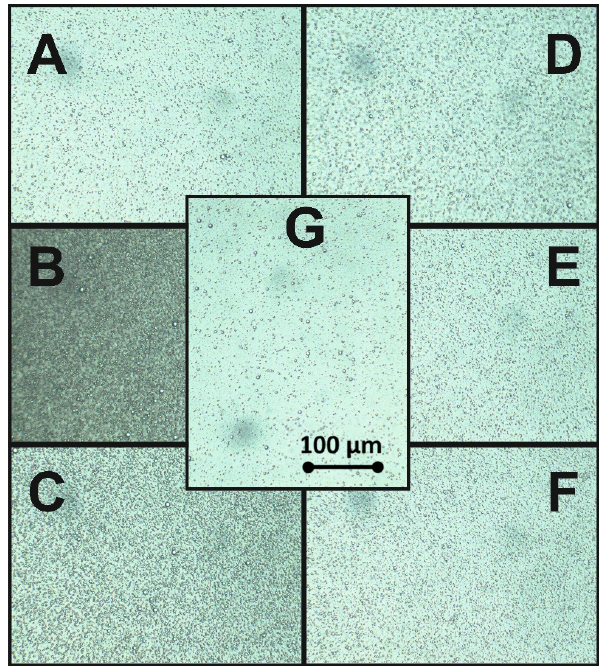
Figure 4. Microscopic images of hempseed oil (HSO) base emulsion with: Quillaja ( A ) 0.5 critical micelle concentration (CMC), ( B ) 1.0 CMC, ( C ) 2.0 CMC and Saponaria ( D ) 0.5 CMC, ( E ) 1.0 CMC, ( F ) 2.0 CMC and ( G ) the references sample O / W emulsion without surfactants. Molecules 2020 , 25 , x